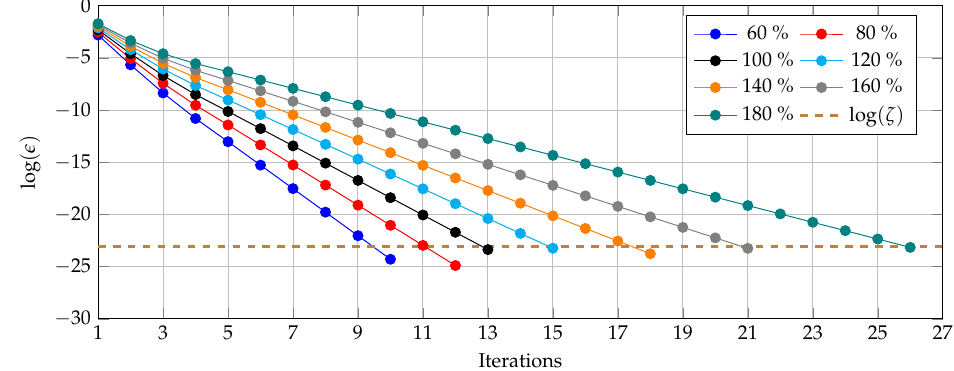
Figure 4. Convergence rate of the studied method for load variations in the 21-bus